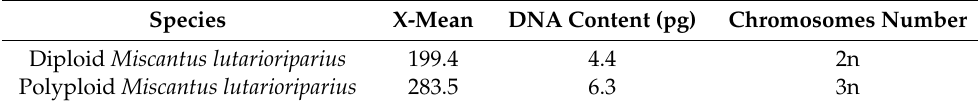
Table 1. Chromosome ploidy of Polyploid Miscantus